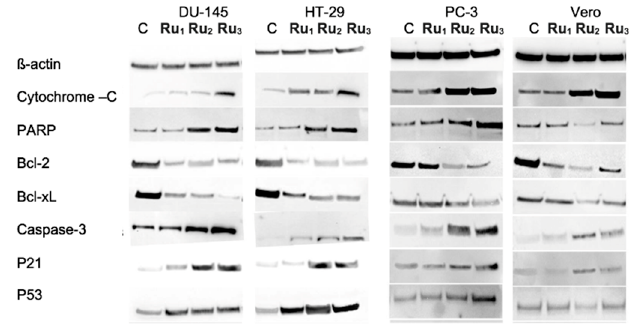
Figure 4. Immunoblot analyses in Du-145, HT-29, PC-3 and Vero cells after 48 h of Ru complexes